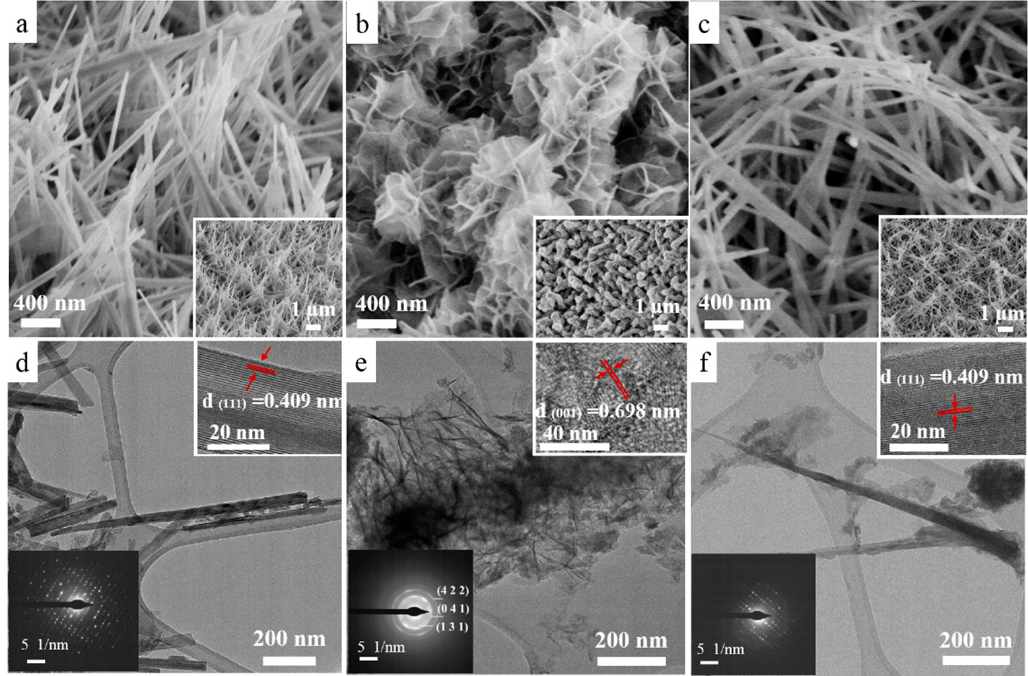
Figure 2. Field emission scanning electron microscopy (FESEM) images ( a – c ) of Samples I, II, and III. The insets show a large-area view of each sample. Transmission electron microscopy (TEM) images ( d – f ) of three samples. The insets in each TEM image show the corresponding selective area electron diffraction (SAED) pattern and high-resolution TEM (HRTEM) image.